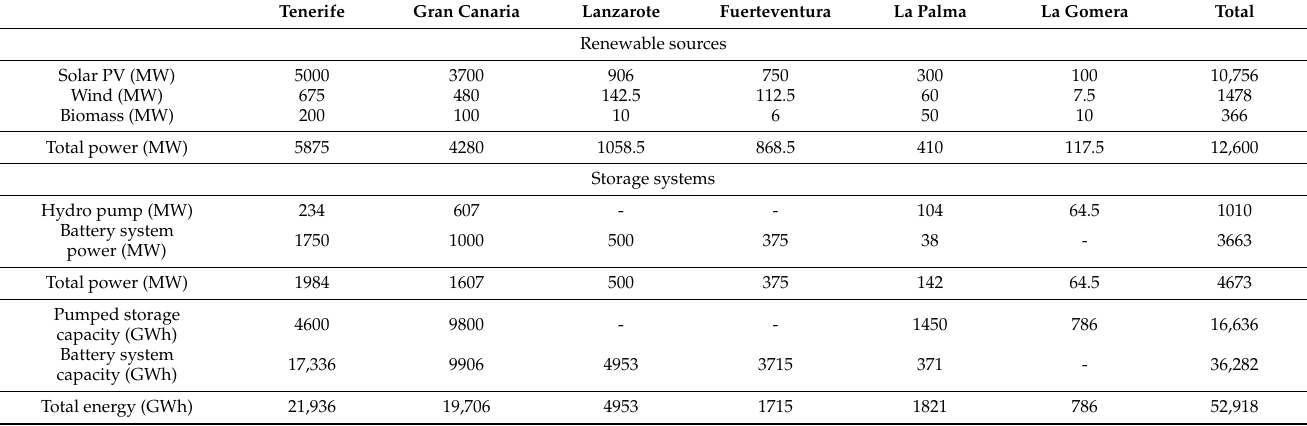
Table 7. Summary of the installed generation power and storage power and capacity.